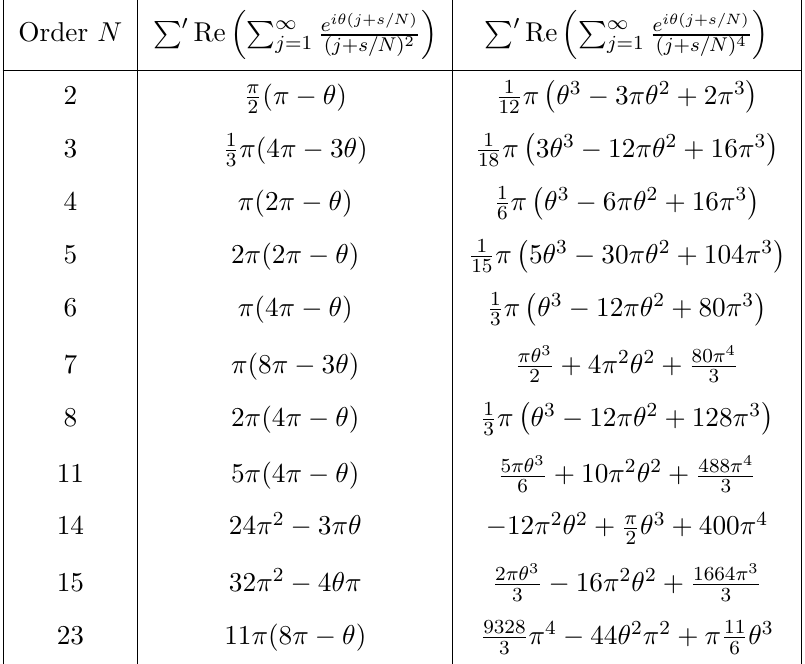
Table 2 . Residues corresponding to orbifolds of K 3. P 0 corresponds to summing over those sectors s where gcd( N; s ) =